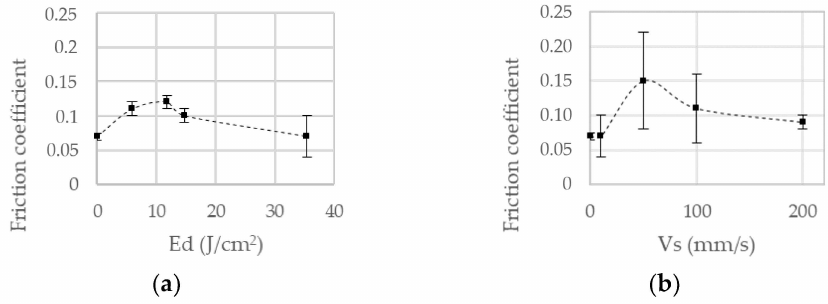
Figure 9. Friction coefficient average values: ( a ) For different Ed at fixed Vs = 10 mm/s; ( b ) For different Vs at fixed Ed = 35.37 J/cm 2